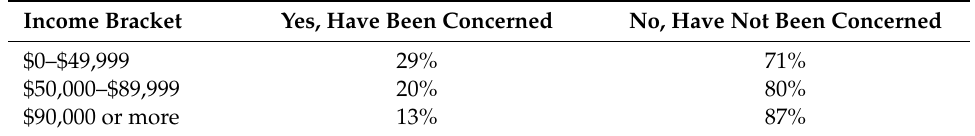
Table 2. Perceived risk of HMM soil contaminants on health by participants with and without children. Children or No Children Very Low Risk Low Risk Neutral High Risk Very high Risk Children 0% 6.7% 17% 23% 53% No Children 0% 14% 29% 43% 14% Total question respondents: 44. Table 3. The concern of participants with eating or buying produce grown in gardens by income level. Income Bracket Yes, Have Been Concerned No, Have Not Been Concerned